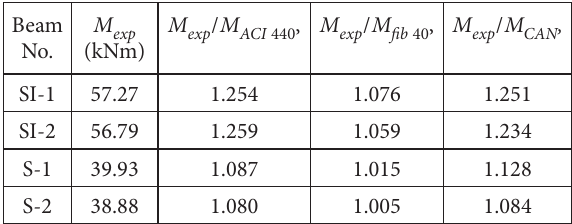
Table 4. A comparison of experimental and theoretical flexural strength